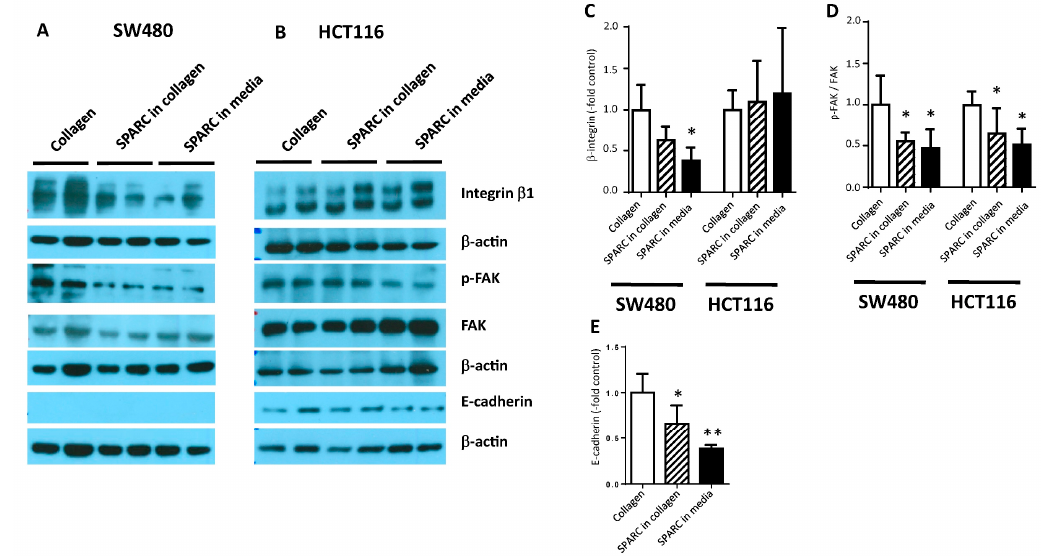
Figure 4. SPARC-induced molecular changes. SW480 ( A ) and HCT116 ( B ) cells were seeded on collagen I. 750 ng / mL SPARC were added to the collagen gel or the culture medium. 24 h later protein lysates were prepared and analyzed by western blotting using antibodies recognizing integrin β 1, FAK, p-FAK and E-cadherin. β –actin was used as loading control. Band intensity was measured using ImageJ software and quantification results of at least 3 independent cultures were pooled. ( C ) integrin β 1, ( D ) relative phosphorylation of FAK, ( E ) E-cadherin in HCT116. * di ff erent from control at p < 0.05. FAK, focal adhesion kinase; p-FAK, phosphorylated